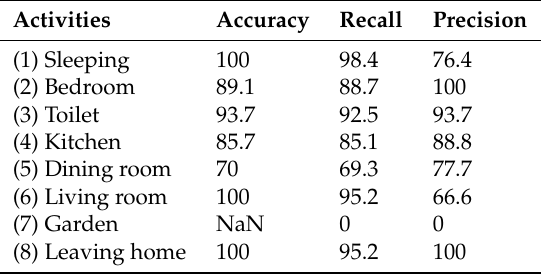
Table 4. Accuracy, recall, and precision for each activity obtained based on